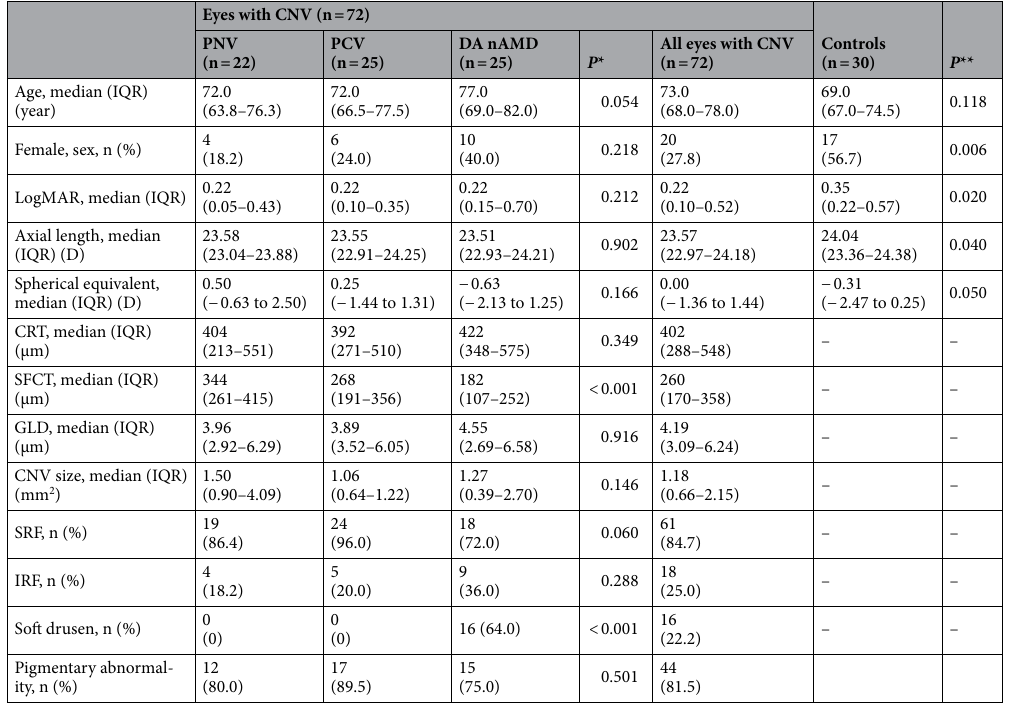
Table 1. Demographics of patients with CNV and controls ar baseline The Kruskal–Wallis test was used for comparisons between three categories. The Mann–Whitney U test was used for comparisons between all eyes with CNV patients and controls. nAMD, neovascular age-related macular degeneration; PNV, pachychoroid neovasculopathy; PCV, polypoidal choroidal vasculopathy; DA nAMD, drusen-associated neovascular age- related macular degeneration; SD, standard deviation; PVD, posterior vitreous detachment; CRT, central retinal thickness; SFCT, subfoveal choroidal thickness; GLD, greatest linear dimension; CNV, choroidal neovascularization; SRF, subretinal fluid; IRF, intraretinal fluid. *The Kruskal–Wallis test was used for analyses among the nAMD subtypes. **The Mann–Whitney U-test was used for analyses between all nAMD and controls.